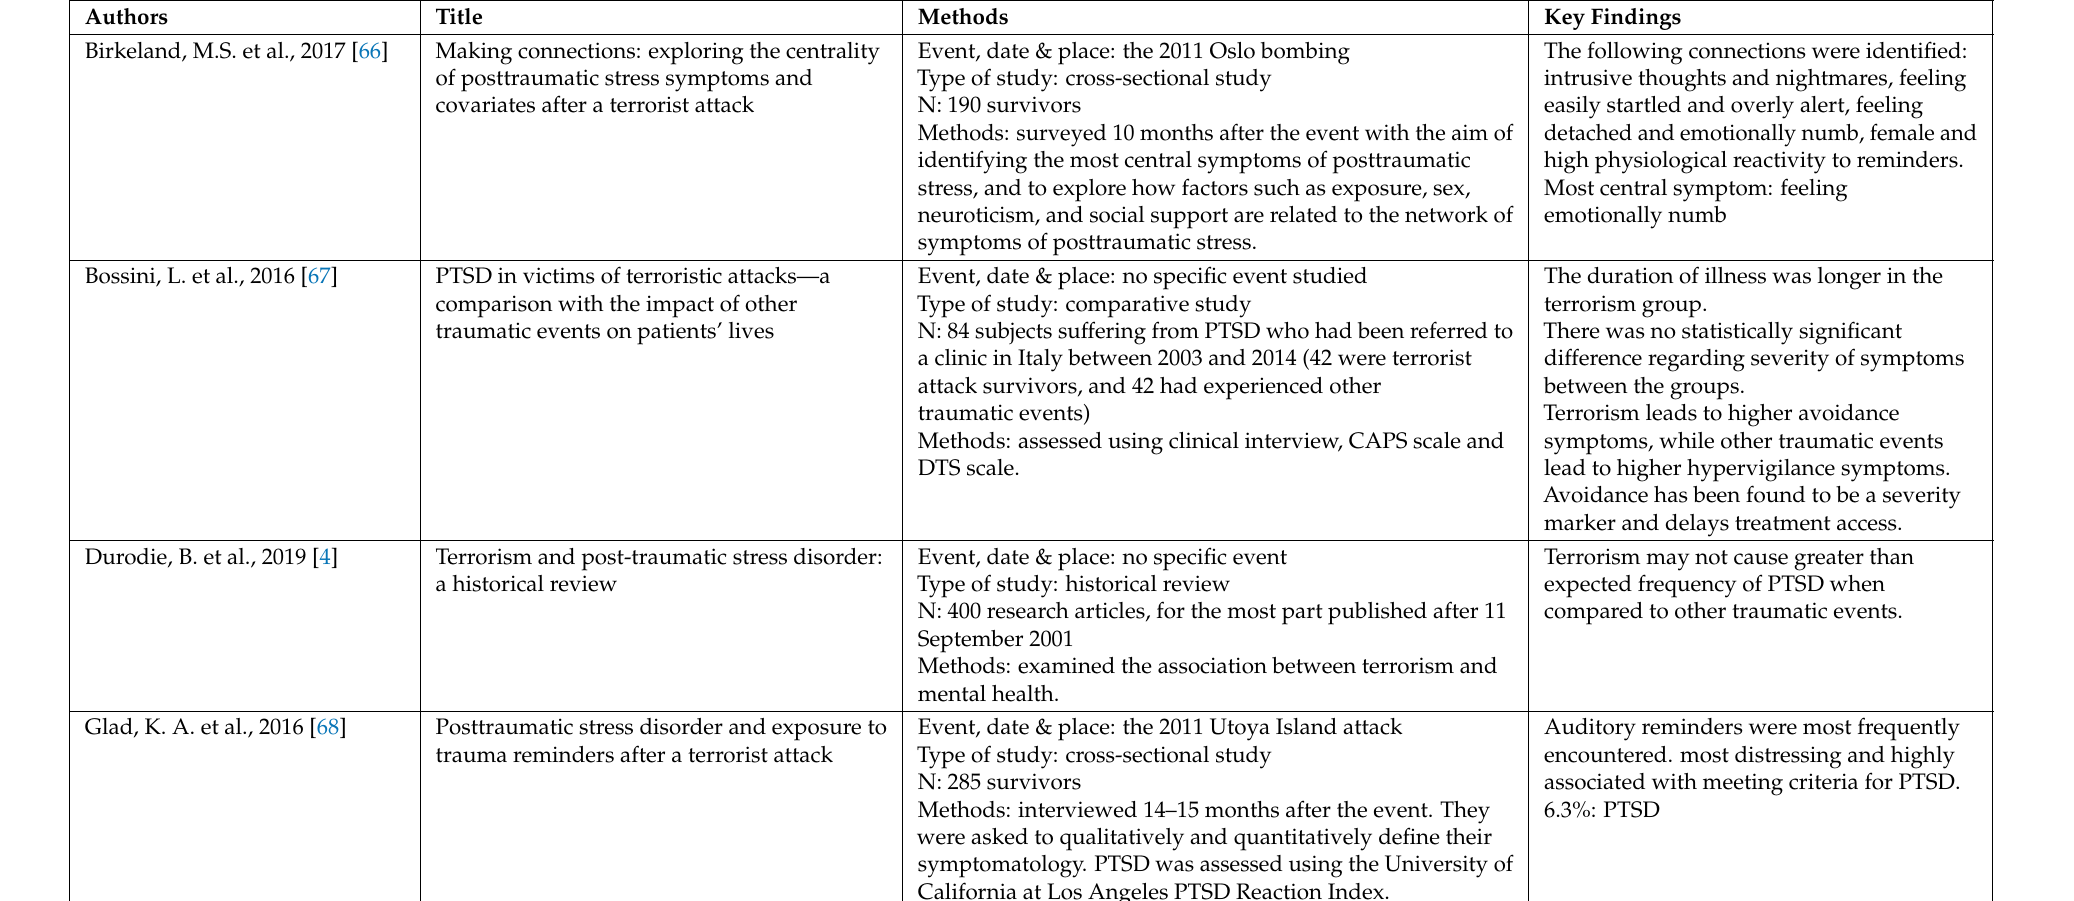
Table 4. Symptom clusters and illness